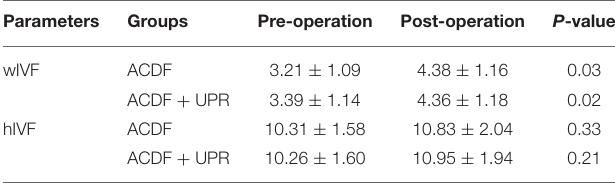
TABLE 2 | The change of width and height of intervertebral foramen in different treatment groups. Parameters Groups Pre-operation